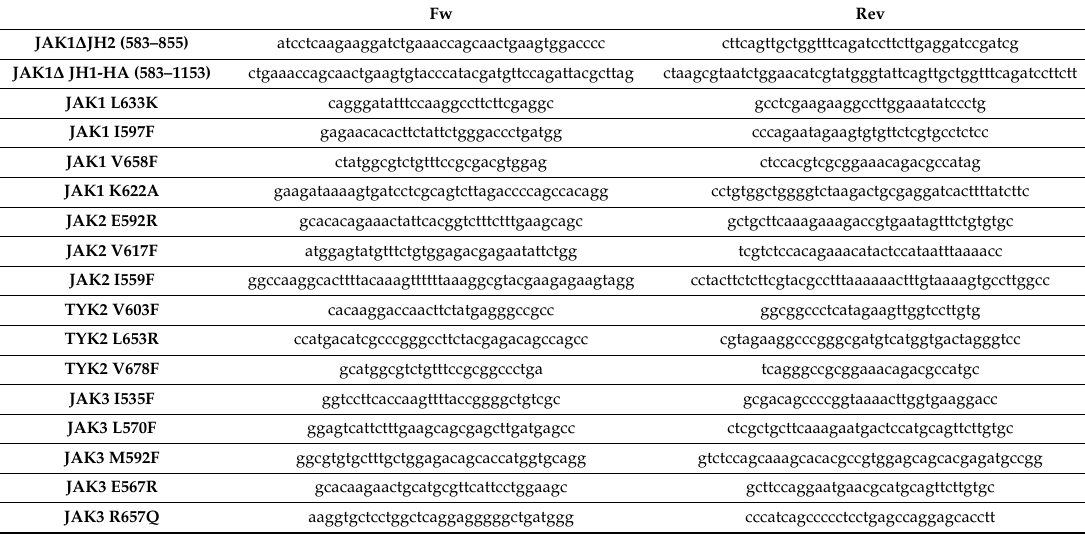
Table 2. Primer sequences for mutations used in this study: